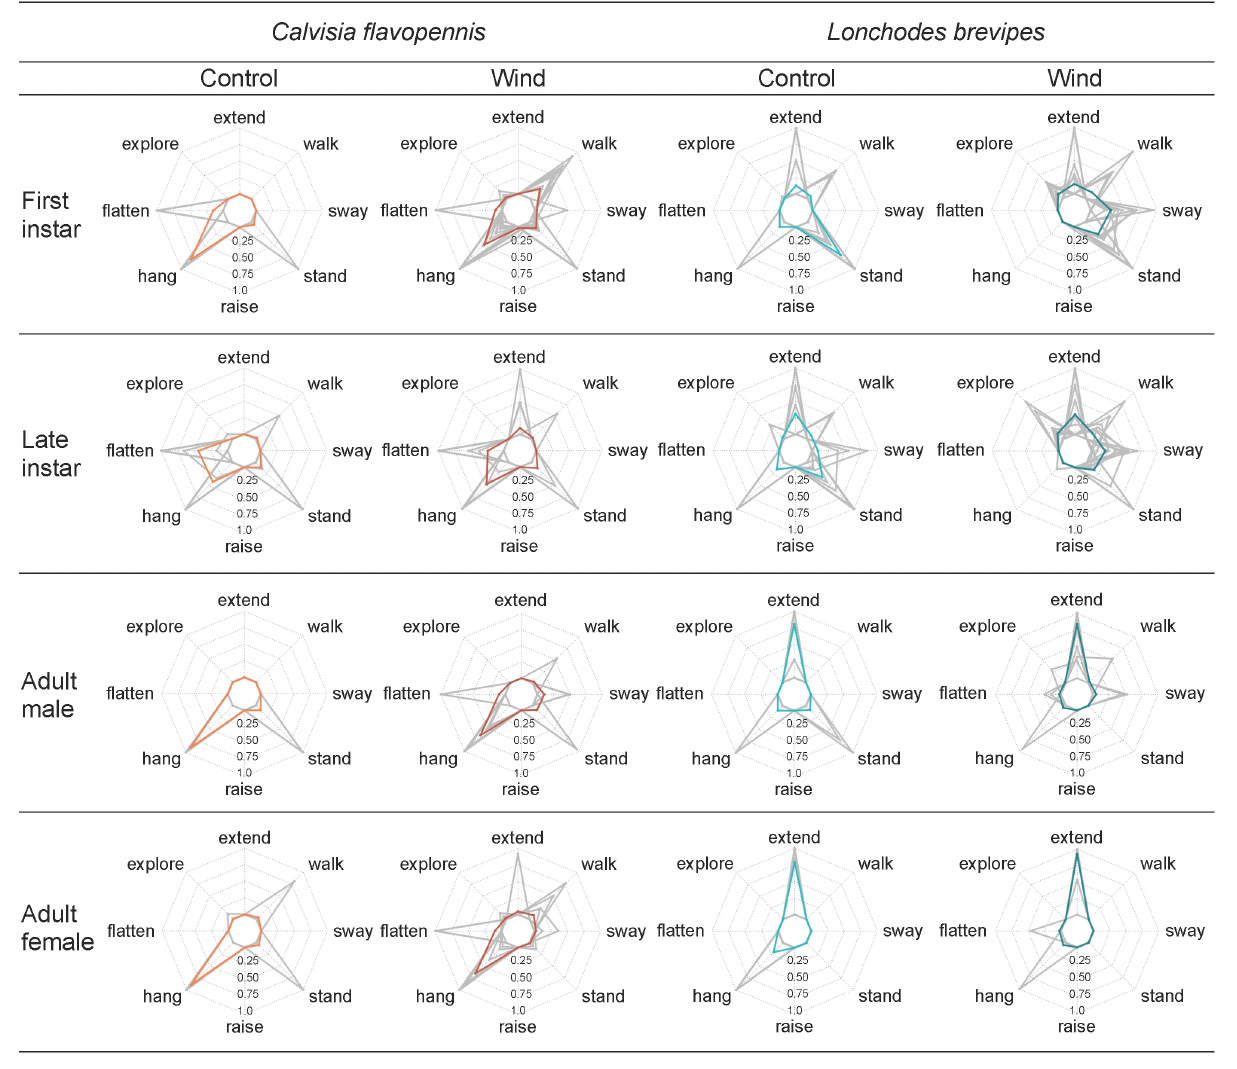
FIGURE 4 | Radar plots display the proportion of time that individuals of different groups (characterized by morphological type and treatment) spent on behaviors that significantly contributed to the distribution pattern during non-metric multidimensional scaling (NMDS). Mean values for each combination of life stage (rows) and treatment (columns) are represented in red for C. flavopennis and in blue for L. brevipes . Gray lines correspond to individual